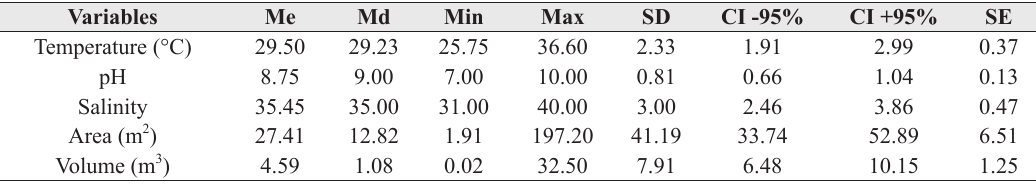
Descriptive statistic of abiotic factors of tide pools on Guarás Island, Curuçá, State of Pará (Me = Mean; Md = Median; Min = Minimum; Max = Maximum; ST = Standard Deviation; CI = Confidence Interval; and SE = Standard